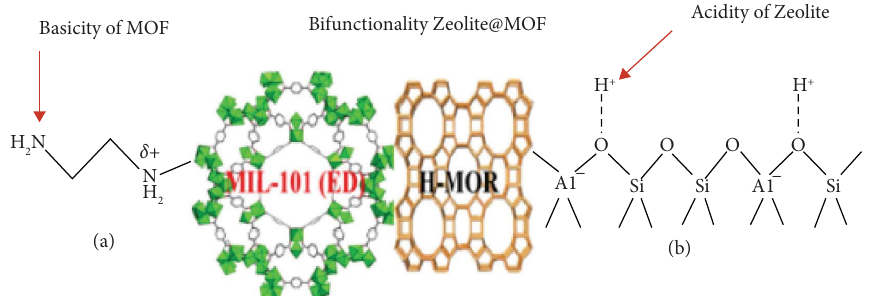
Figure 29: Bifunctionality of Zeolite@MOF catalyst modifed from